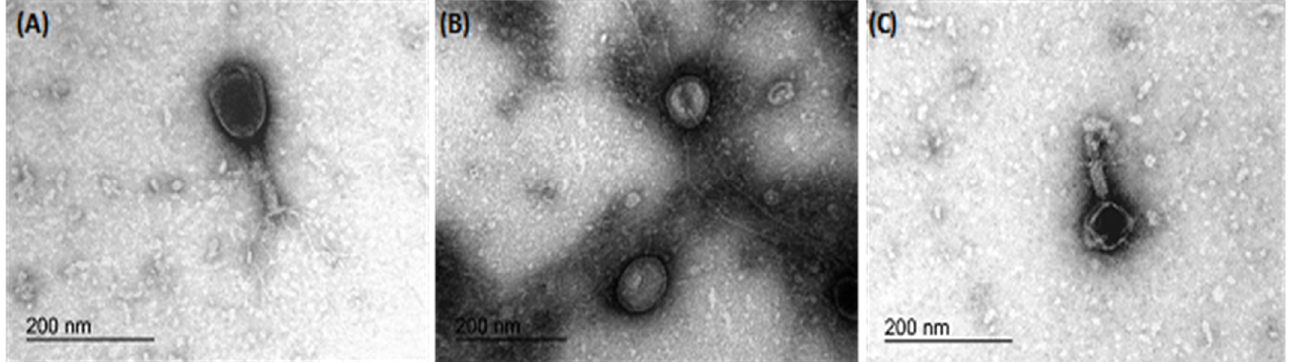
Figure 3. Representative transmission electron microscopy micrographs of bacteriophages ( A ) IBEC 36, ( B ) IBEC 77, and ( C ) IBEC 48 isolated from clinical samples against E. coli LF82, E. coli CFT073, and E. coli MG1655, respectively. All were only active against the representative strains and were not cross-reactive. (Bar = 200